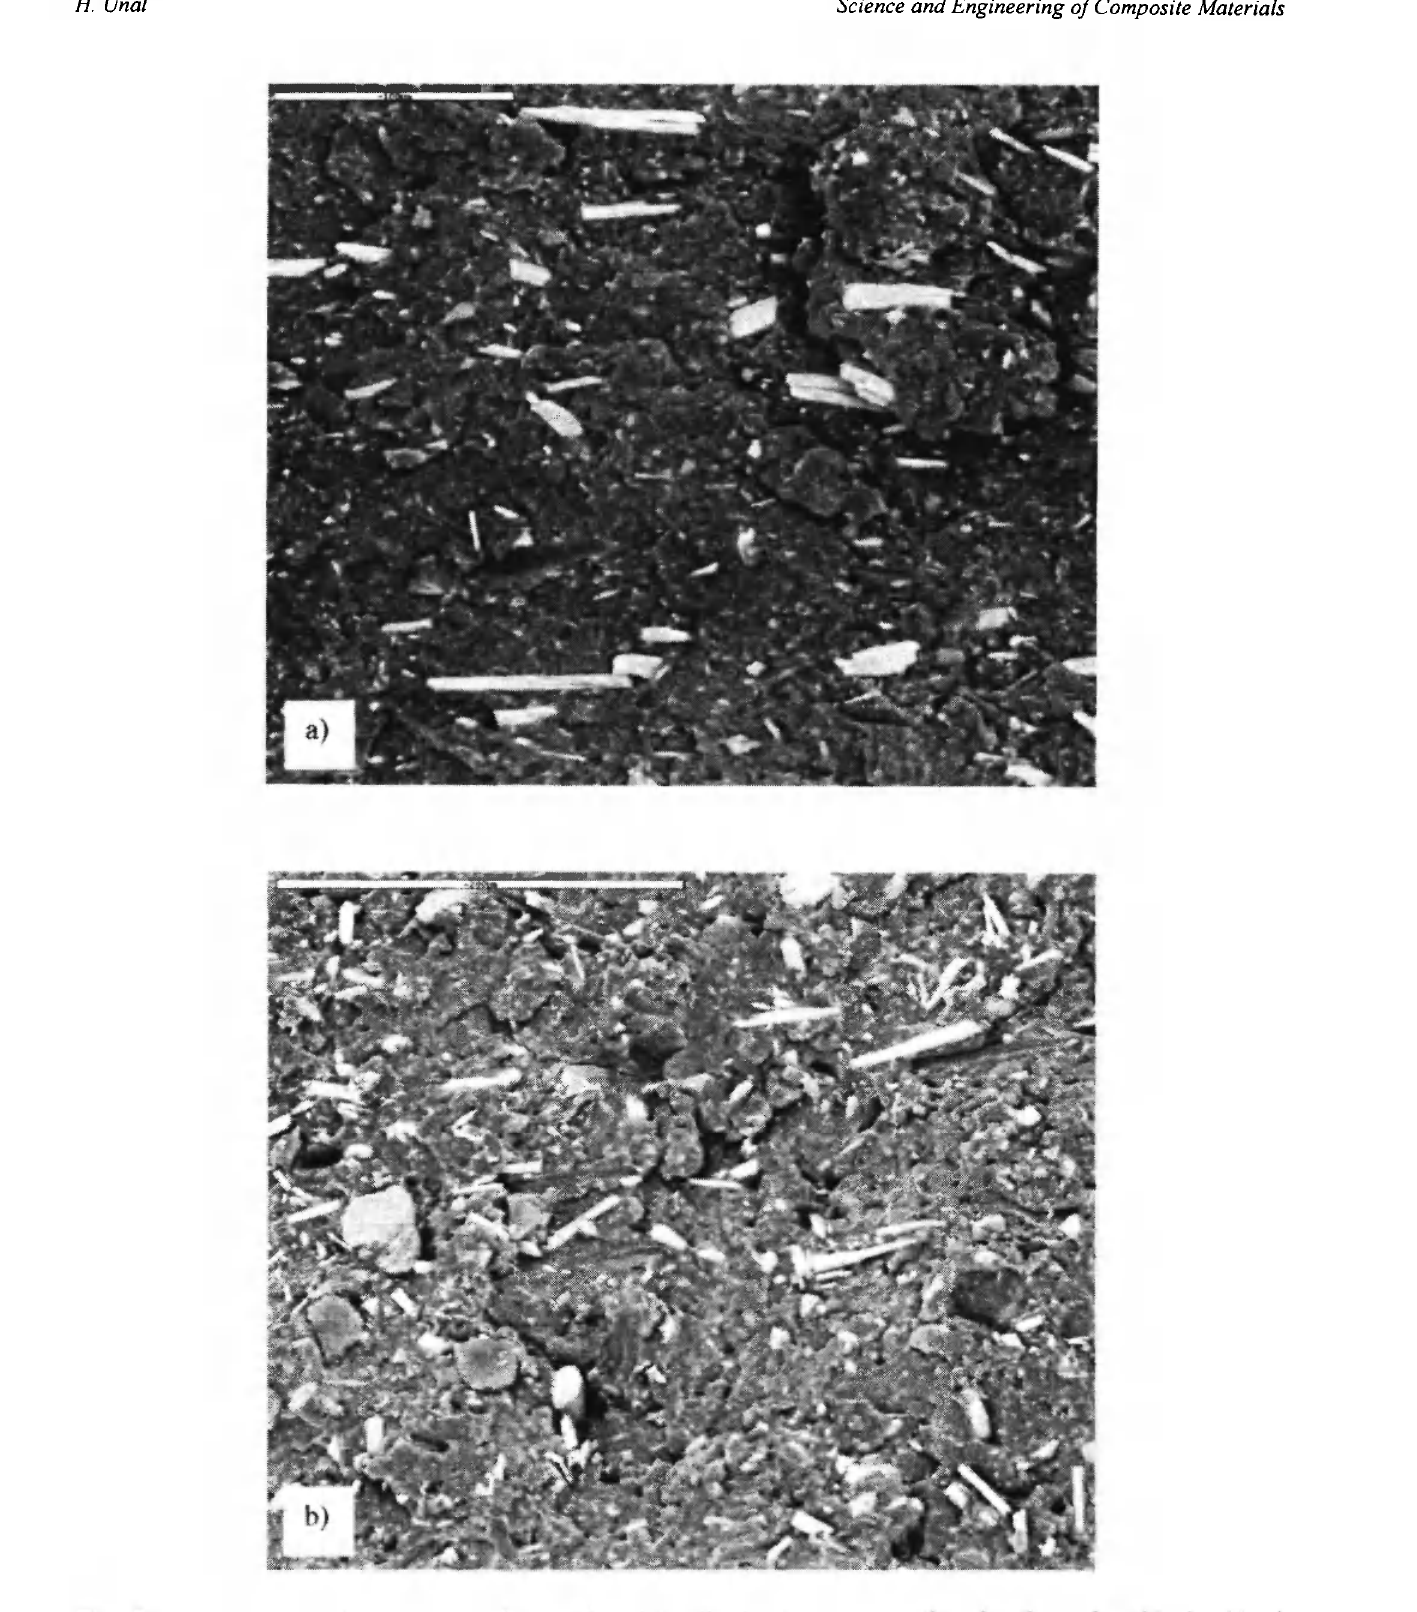
Fig. 7 a and b: Scanning electron micrographs of tensile fracture cross-section for the polyamide -6 with a) 10wt.%wollastonite+20wt.% kaolin b) 20wt.% wollastonite+lOwt.